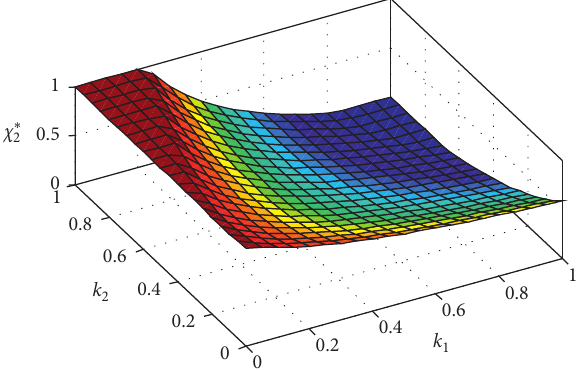
Figure 3: Relationship between the effort degree of the con- struction enterprise χ ∗